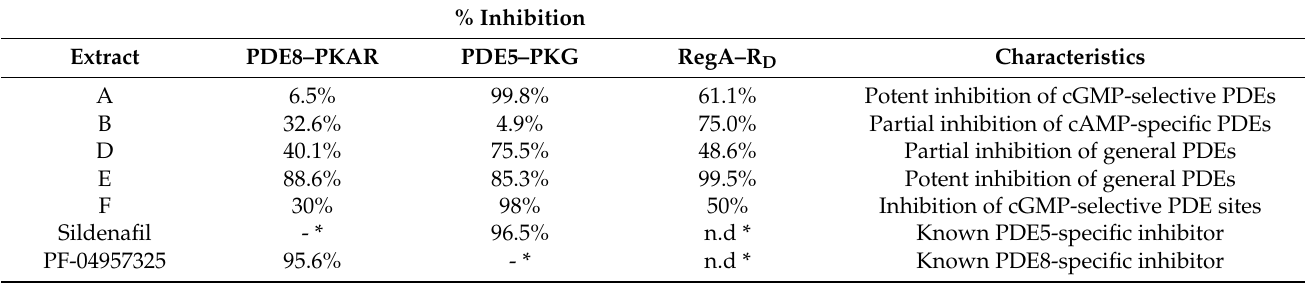
Table 1. Summary of the % inhibition of extracts obtained from fluorescence polarization assay results using specific PDE–PK pair as the